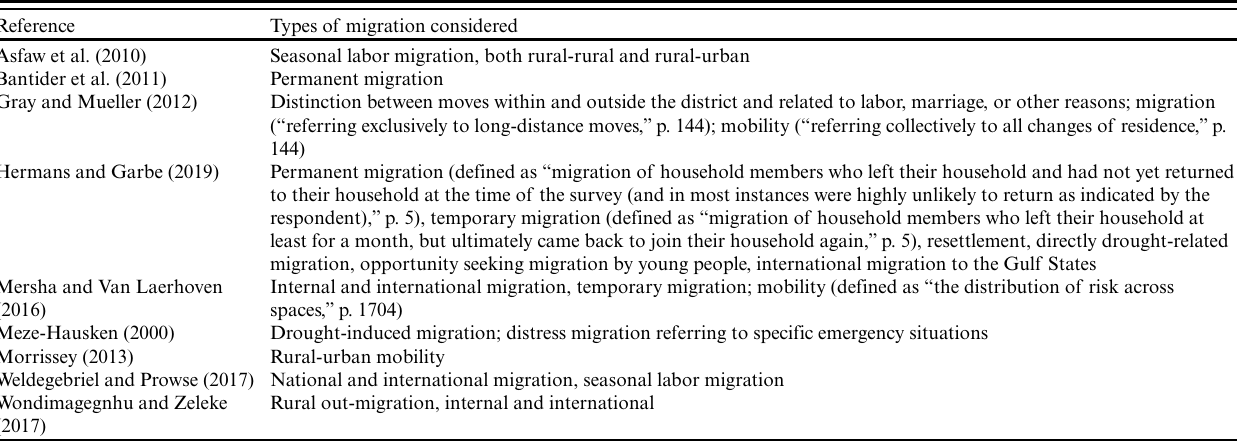
Table 2 . Selected case studies from the Ethiopian highlands and the respective types of migration considered in each study. Reference Types of migration